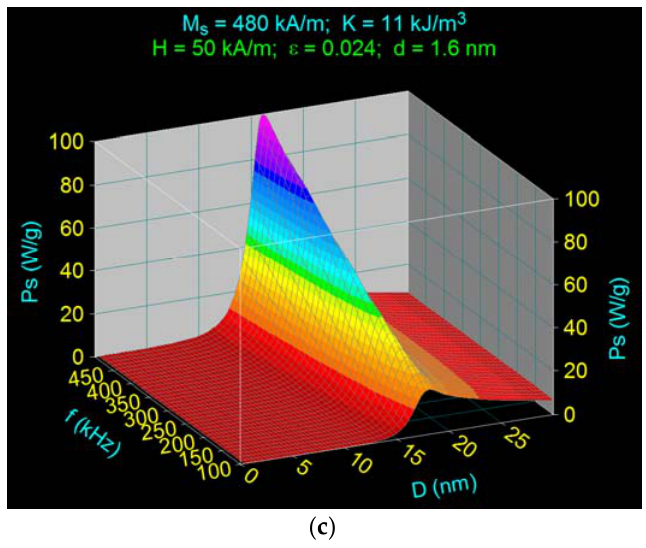
Table 2. Maximum specific loss power and diameters corresponding with the maximums in the case of dispersed Fe 3 O 4 – γ - CDs bionanoparticles.